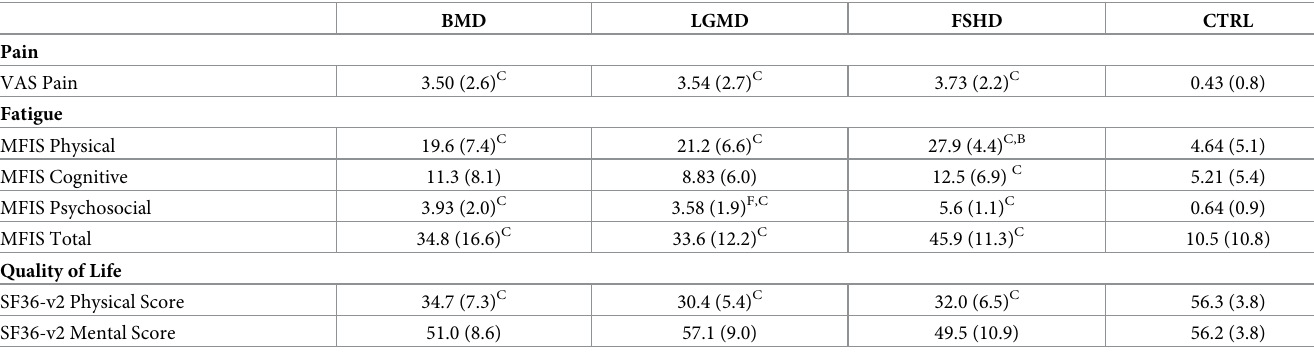
Multiple linear regressions. In BMD, MFIS Physical was identified as the strongest rela- tionship with PSQI (R 2 = 0.588, P = 0.001), with all other variables excluded. Body Fat (%) was identified as the strongest relationship with Severity Index (R 2 = 0.358, P = 0.018), with all other variables excluded. No models were identified including any variables for Sleep Time or Sleep Efficiency in BMD (P > 0.05). Table 3. Pain, fatigue and quality of life in adults with